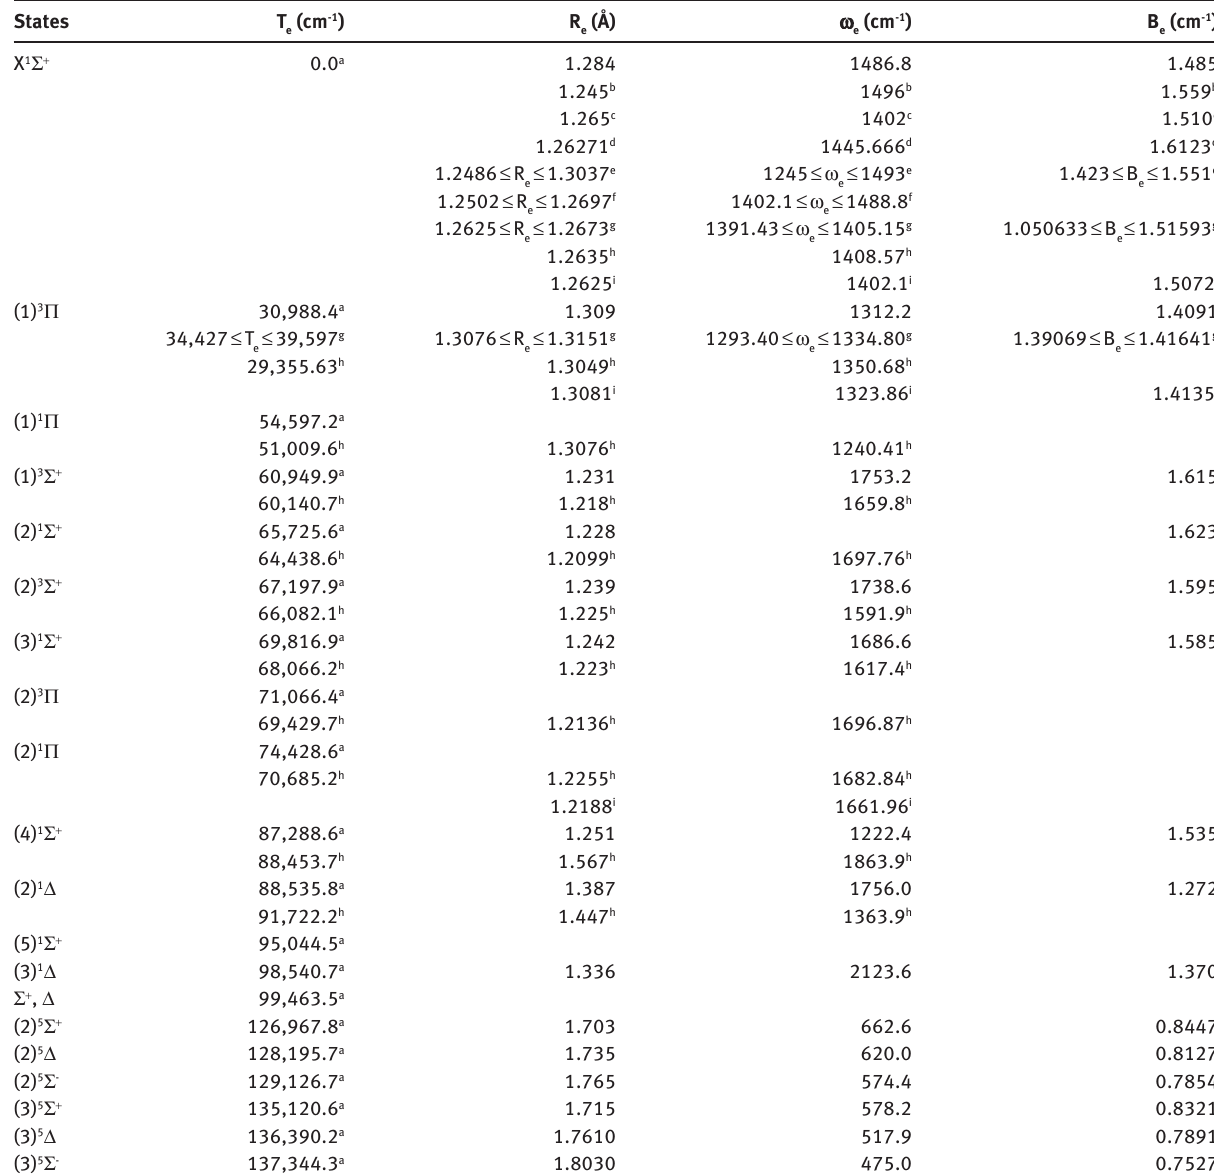
Table 1: Spectroscopic constants of the molecule BF.